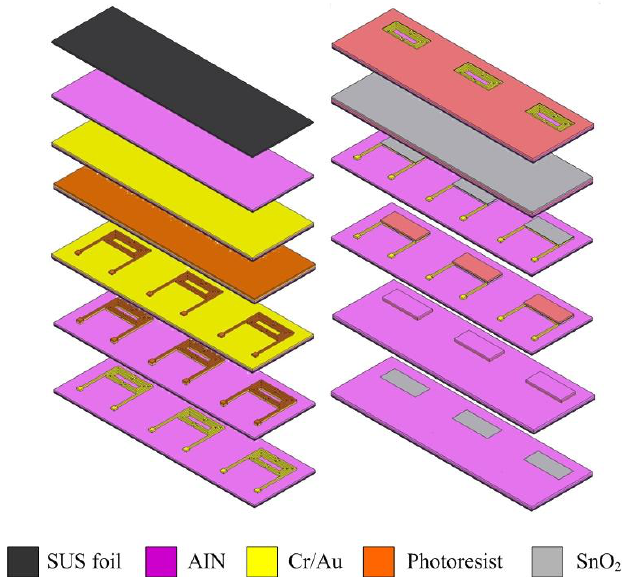
Figure 1. Fabrication flowchart of a flexible micro CO